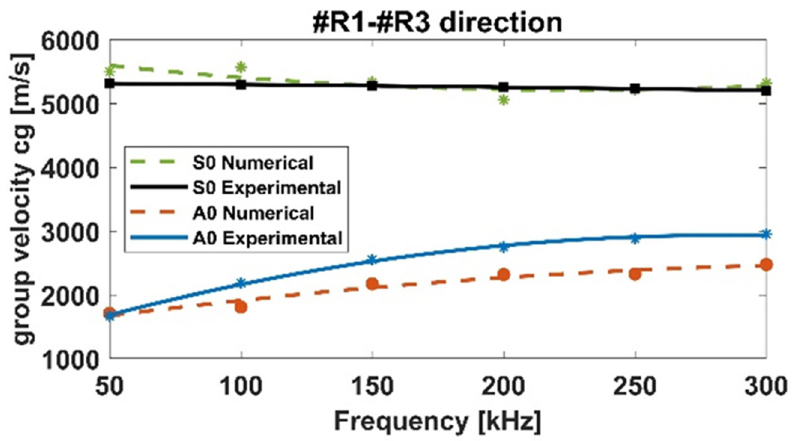
Figure 4. Dispersion curves for the flat aluminum panel.